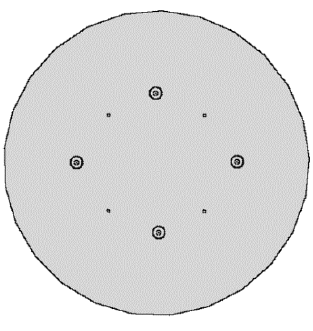
Figure 16. Distribution of the burners on the roof of the reactor. The large openings are burners and the small openings are powder feeding ports.